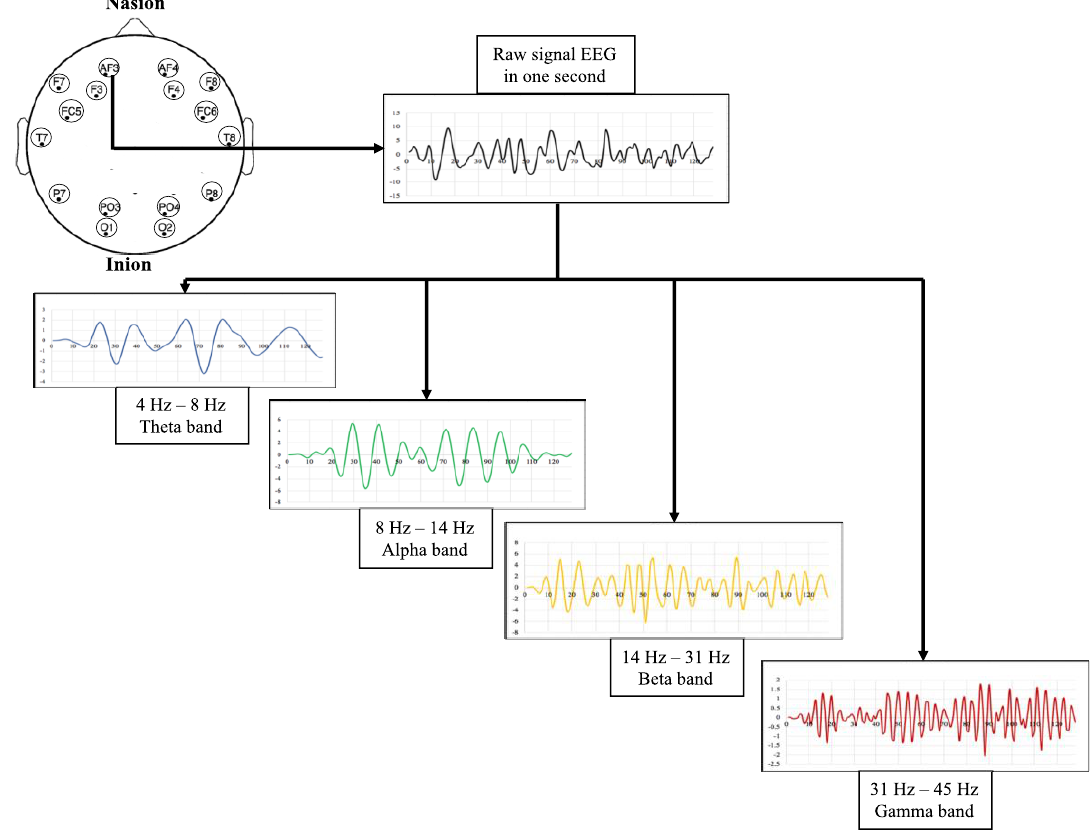
Figure 2. Illustration of the decomposition processes for AF3